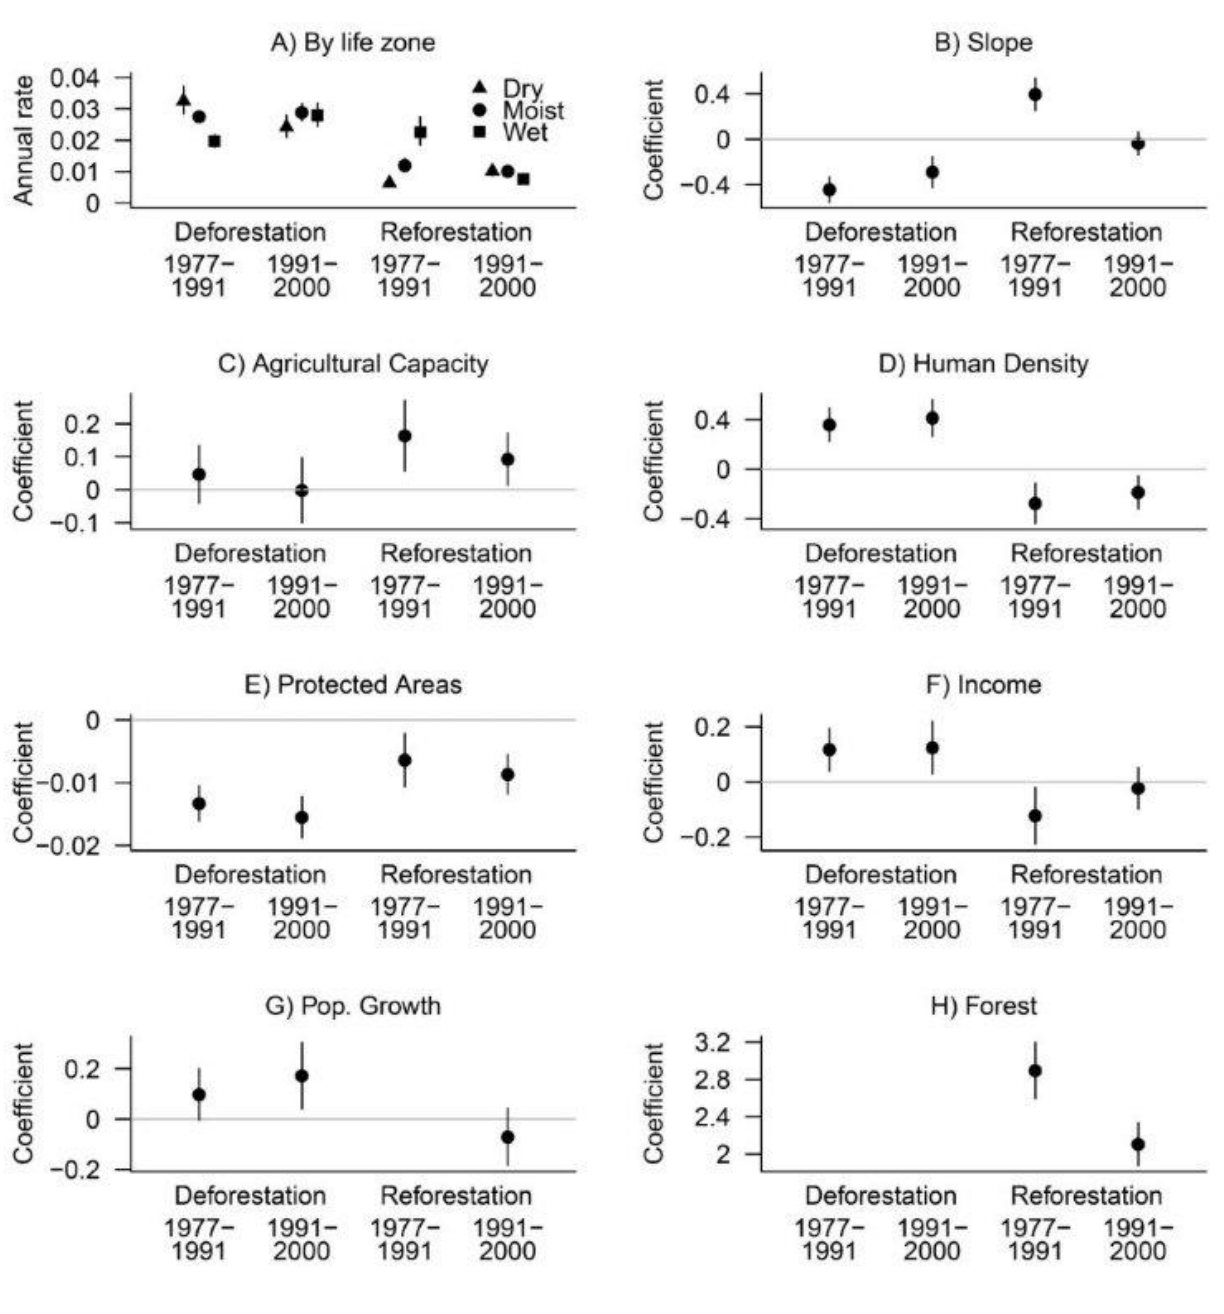
Fig. 3. Estimated annual deforestation and reforestation rates during the two study periods for the (A) three life zones (with all other covariates set to their mean values) and standardized regression coefficients for (B) slope, (C) soil agricultural capacity, (D) population density, (E) percentage of municipality in protected areas, (F) average income (in 2000 US$), (G) population growth rates during the analyses period, and (H) total amount of forest (only included in reforestation models). Bars indicate two standard errors above and below estimated